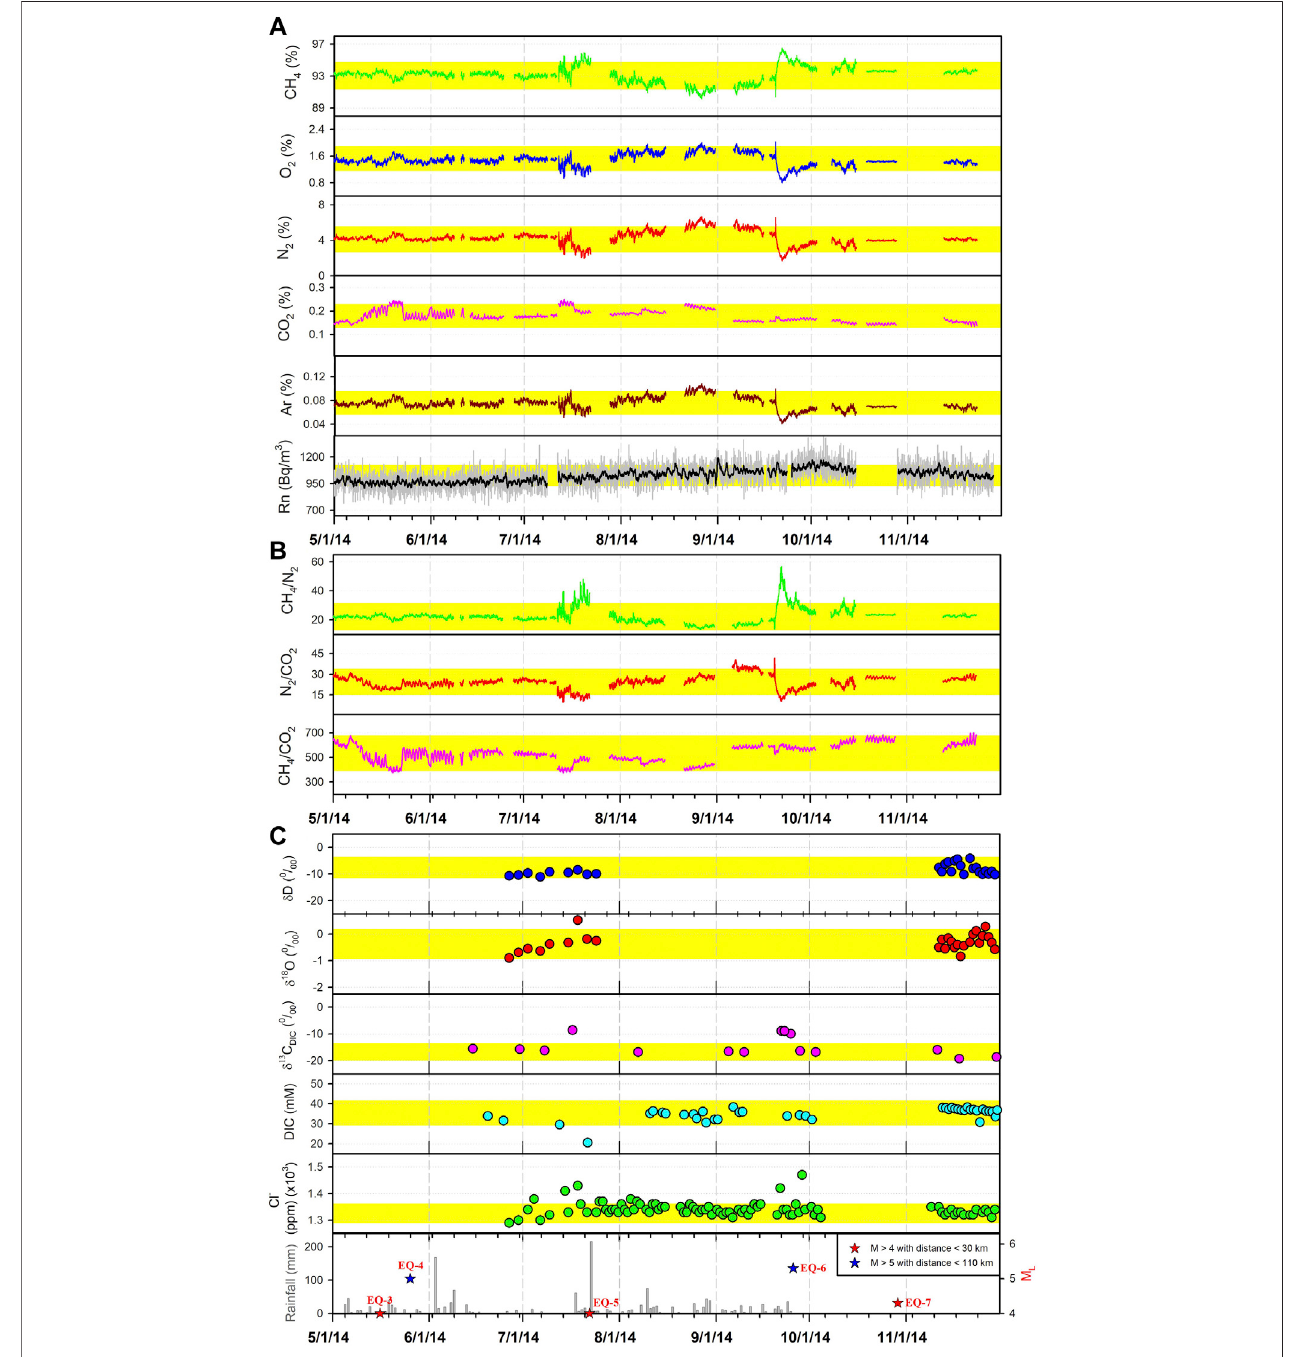
FIGURE5| Thetemporalvariationsof (A) concentrationand (B) ratioofdissolvedgases aswellas (C) waterchemicalcompositions( δ D, δ 18 O,and δ 13 C DIC values along with DIC and chloride concentrations) from May 1 to November 30, 2014. Horizontal yellow bar indicates two standard deviations from the mean of the observed results. The magnitude of related earthquakes with local intensity ≥ 2 and hourly rainfall data are also included. The star symbols in different colors indicate that the epicenter distance of the earthquake to the station was ≤ 30 km (red) with a magnitude ≥ 4 and ≤ 110 km (blue) with a magnitude ≥ 5, respectively.